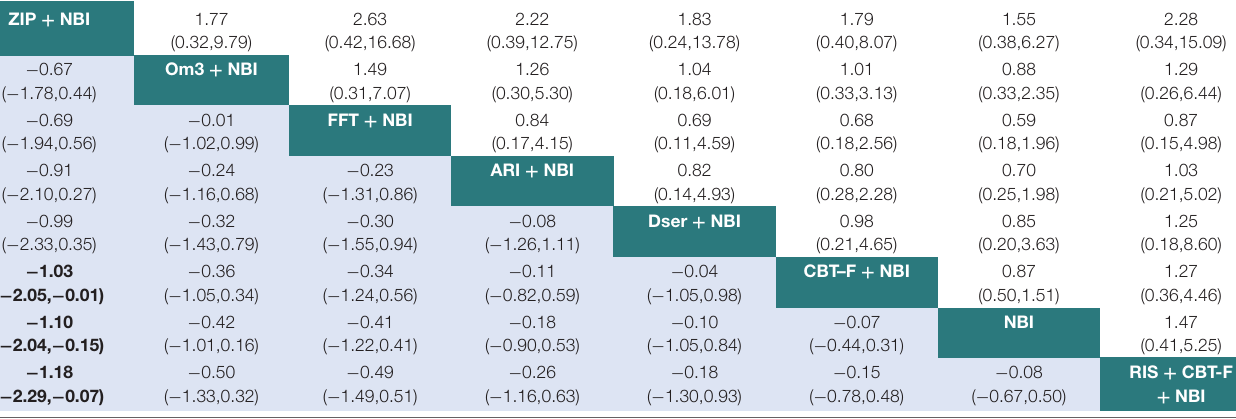
Comparisons between treatments should be read from left to right, and the estimate is in the cell in common between the column-defining treatment and the row-defining treatment. For the primary outcome (attenuated positive psychotic symptoms) estimates, results are SMD (95% CI), where SMD below 0 favors the column-defined treatment. For acceptability, results are OR (95% CI), where OR < 1 favors the row-defined treatment. Significant results are in bold. The order of treatments in the diagonal is arbitrary and does not reflect ranking. ZIP, ziprasidone; NBI, needs-based interventions (including placebo); Om3, omega-3 fatty acids; FFT, family-focused therapy; ARI, aripiprazole; Dser, D-serine; CBT-F, cognitive behavioral therapy (French & Morrison protocol); RIS, risperidone.